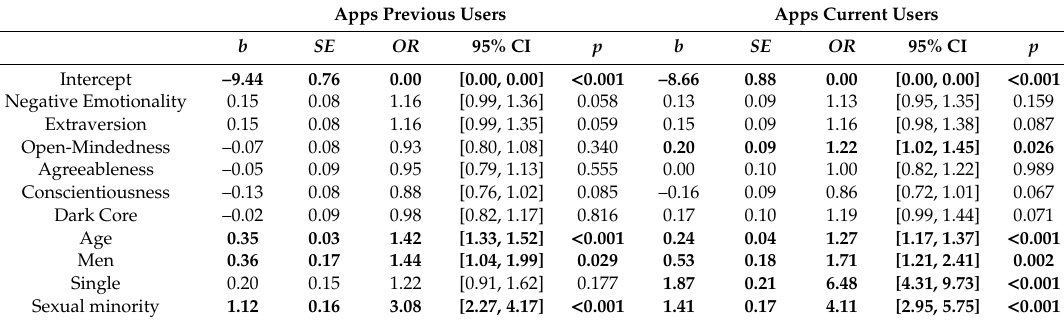
Table 3. Multinomial logistic regression analyses of use of dating